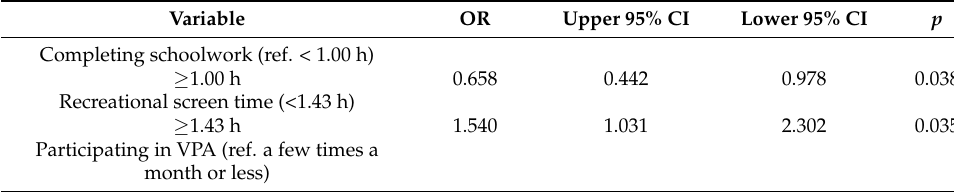
Table 5. Association of depression with sedentary behavior and physical